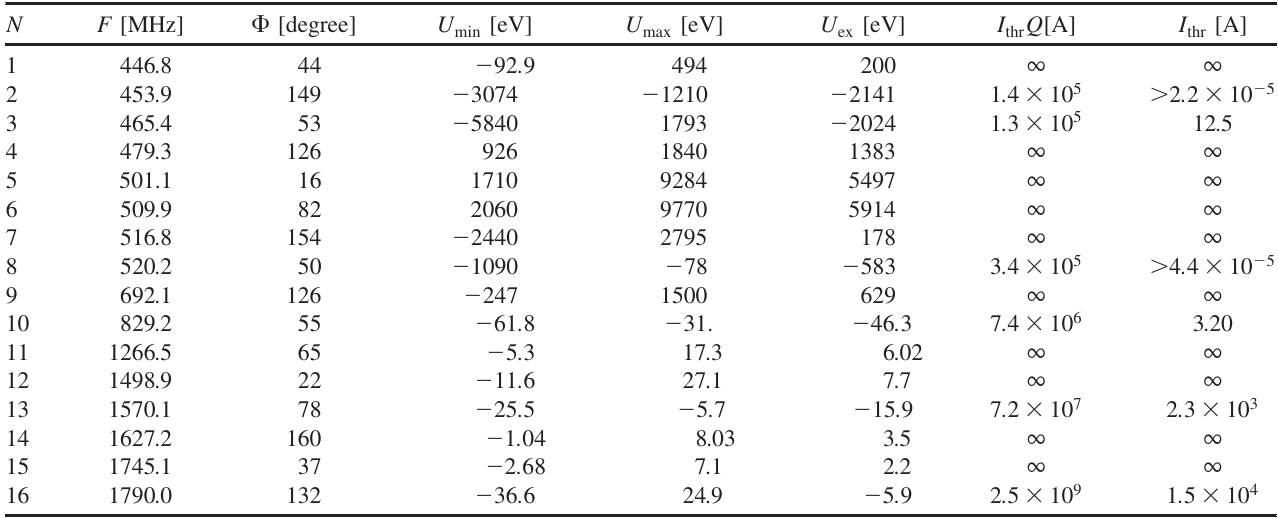
PREDICTION AND SUPPRESSION OF . . TABLE II. Performance of the dipole mode excitation by a weakly relativistic beam in the LEP cavity. Particles with initial energy of 2 MeV are accelerated by the TM 010 mode up to 6.35 MeV. B max ¼ 0 : 001 T is the maximum field of dipole modes. I thr is the breakup instability threshold current discussed in the next section, Q (cid:4) Q ex are taken from Table I.